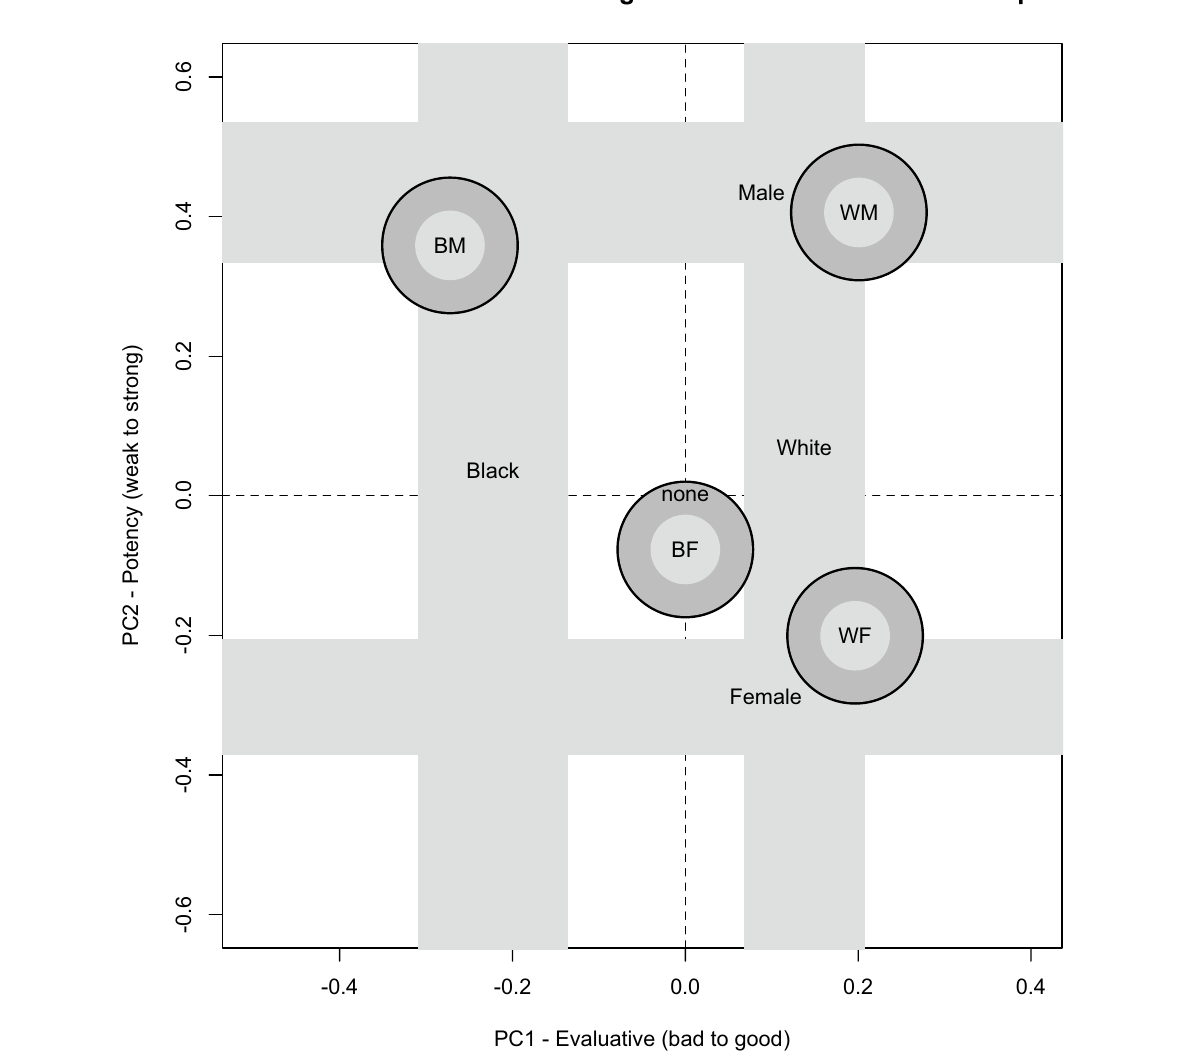
Fig. 1 Intersectional effects of race and gender in the space traditionally defined by the semantic differential. Effects of race or gender labels alone were evident in distinct primary dimensions (evaluative and potency, respectively). Thickness of bars for each of these effects represents two standard errors of the means derived from linear mixed effects regression models comparing each single label to the baseline condition (“none”: no mention of race or gender). Circular symbols (outer radii closely approximate one standard error in each dimension) are shown for cases where both gender and race were specified. Locations of verbal labels show two-dimensional position in the semantic space with respect to the baseline